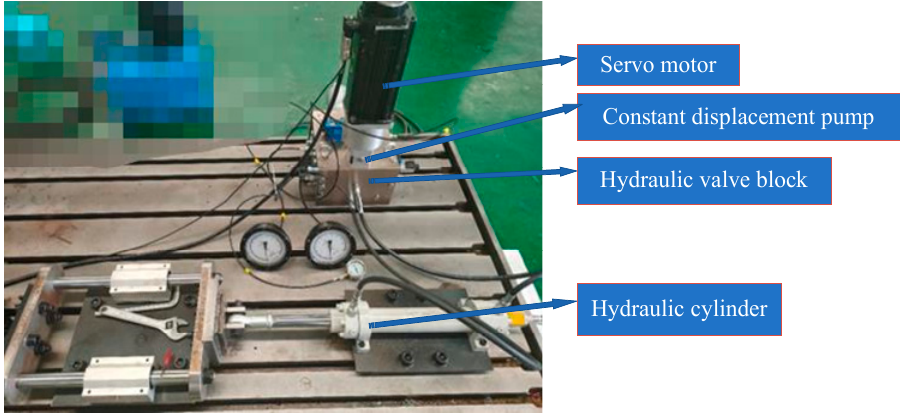
Figure 17. Electro-hydraulic servo pump control test platform.